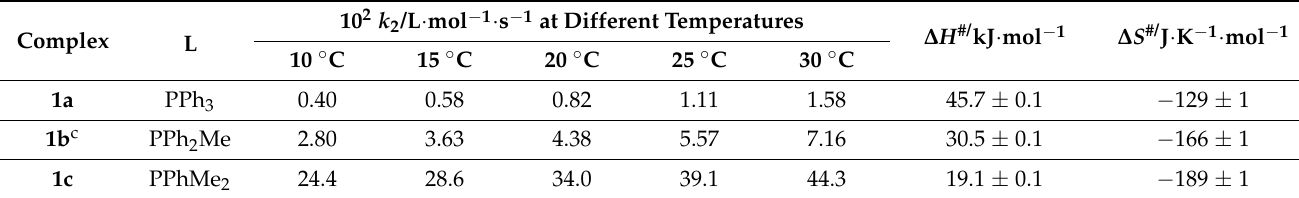
Table 3. Second-order rate constants a and activation parameters b for the reaction of 1 with MeI in acetone c .